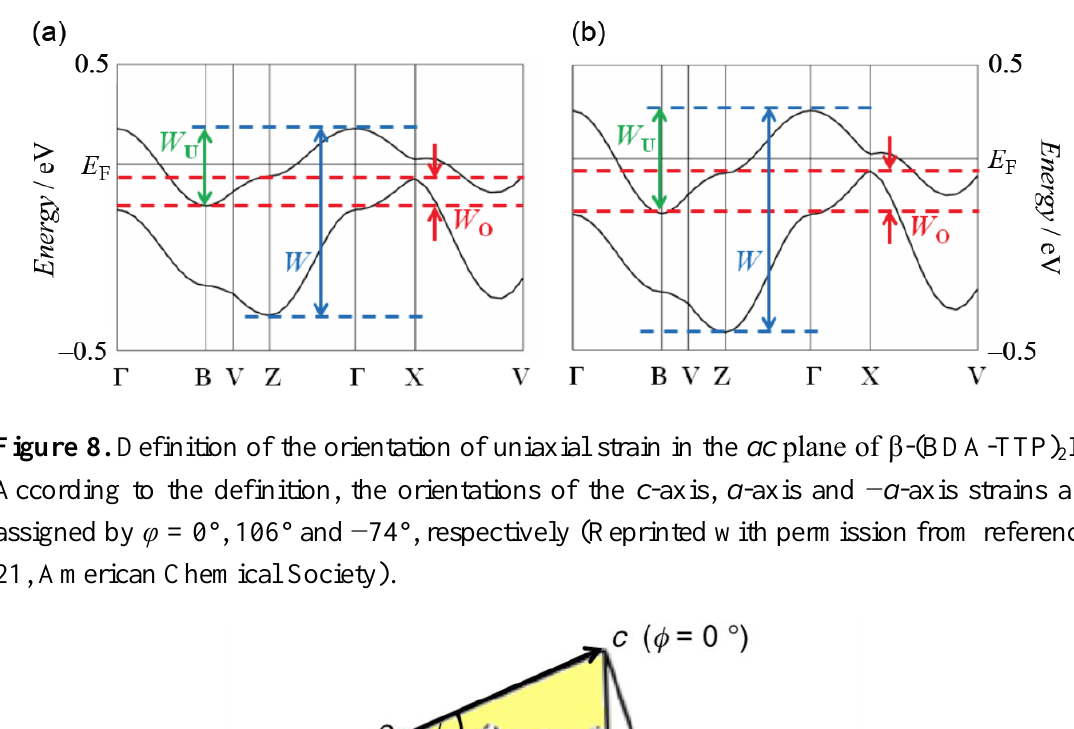
Figure 7. Band structures of β-(BDA-TTP) hydrostatic pressure of 7.5 kbar. The values of W , W 0.27 and 0.09 eV, respectively, whereas those at 7.5 kbar are 0.78, 0.36 and 0.15 eV, respectively (Reprinted with permission from reference 21, American Chemical Society).